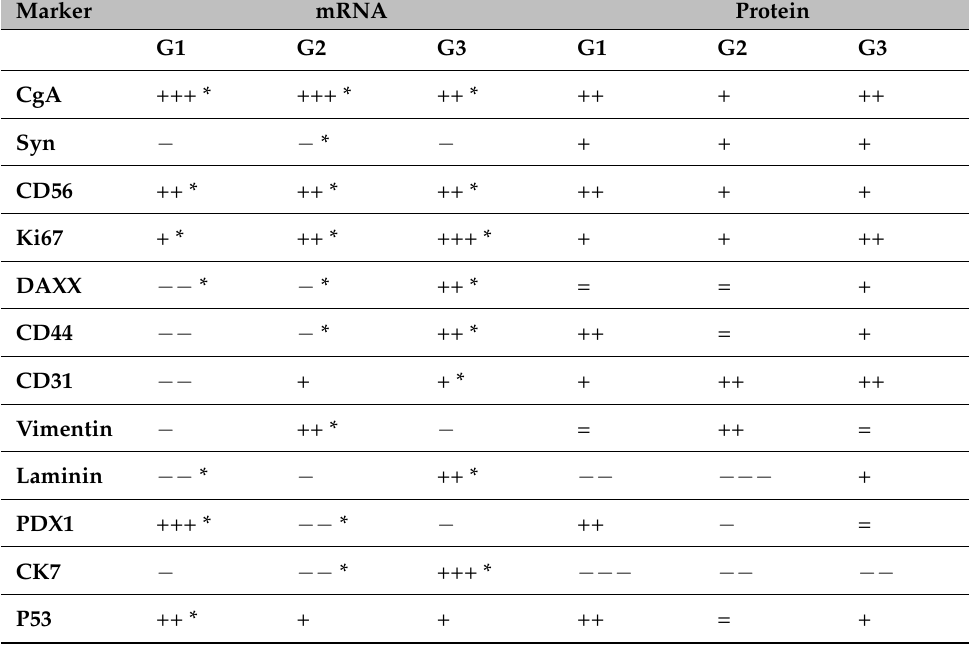
Table 2. Table comparing mRNA and protein levels for selected